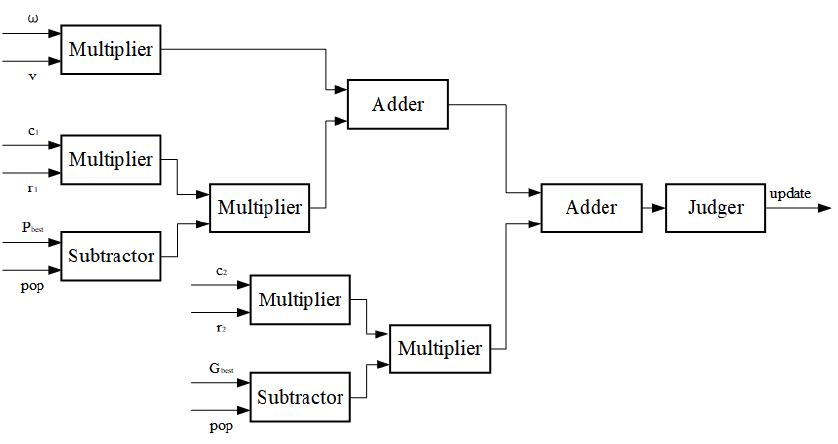
Figure 11. FPGA particle velocity update module.